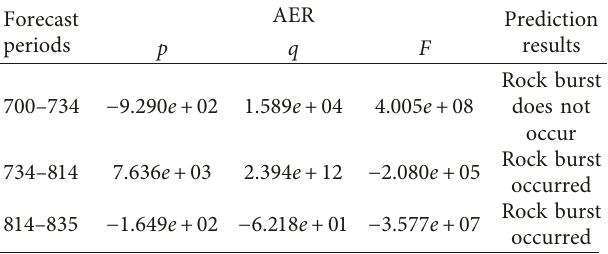
Table 5: Rock burst prediction of cubic granite.